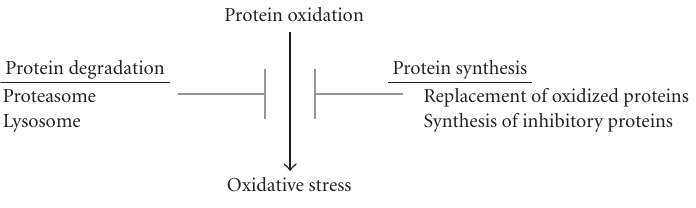
Figure 1: Interplay between protein synthesis, protein degradation, protein oxidation, and oxidative stress. Oxidized proteins are capable of inducing oxidative stress, with oxidative stress a potential mediator of AD pathogenesis. The ability of oxidized proteins to induce oxidative stress is inhibited by protein synthesis and protein degradation pathways. The generation of proteins to replace those which have been oxidized, and the synthesis of proteins which inhibits oxidized protein toxicity (ie, heat shock proteins), inhibits the induction of oxidative stress. Proteolytic pathways (lysosomal, proteasomal) degrade oxidized proteins and thereby ameliorate their ability to induce oxidative